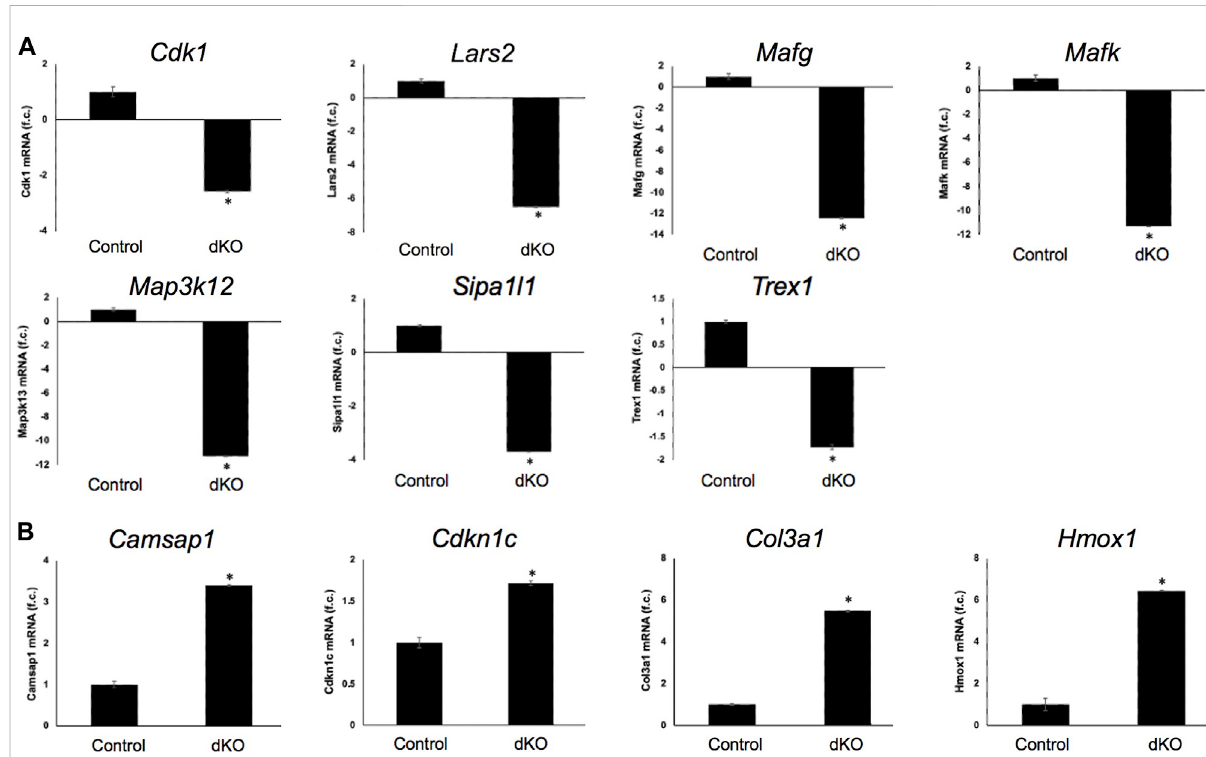
FIGURE 6 RT-qPCR-based validation of differentially expressed genes in Mafg − / − : Mafk − / − lens. Validation by RT-qPCR of several RNA-seq analysis- identi fi ed candidate genes that are (A) down-regulated and (B) upregulated in Mafg − / − : Mafk − / − lenses. Fold-change was calculated using the ΔΔ CT- method using Gapdh as a house-keeping gene and statistical signi fi cance was determined using a two-sample Student ’ s t -test. Asterisk indicates p ≤